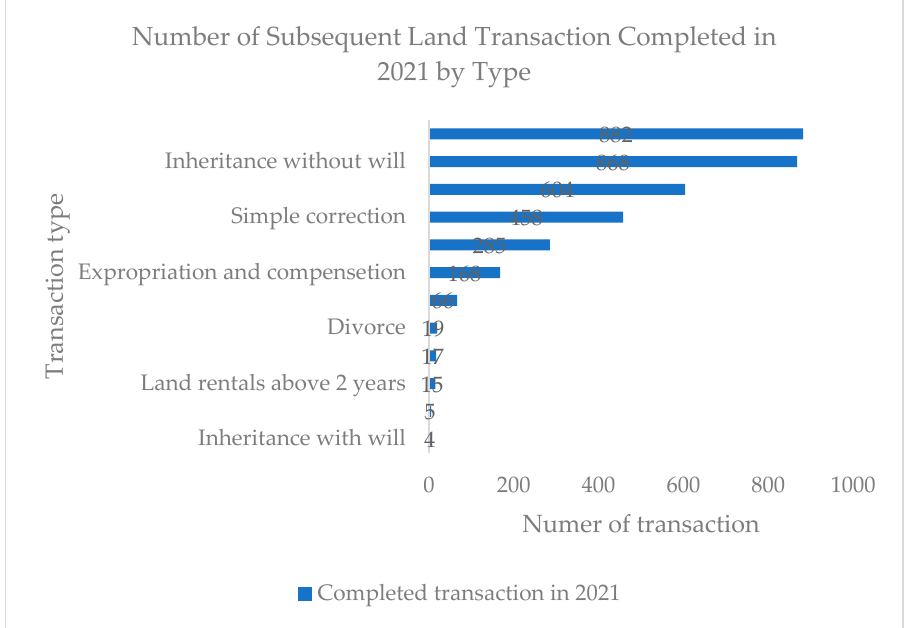
Figure 4. Numbers and types of subsequent land transactions completed in the year 2021. Source: Basona Werena woreda land office digital land register, called NRLAIS.